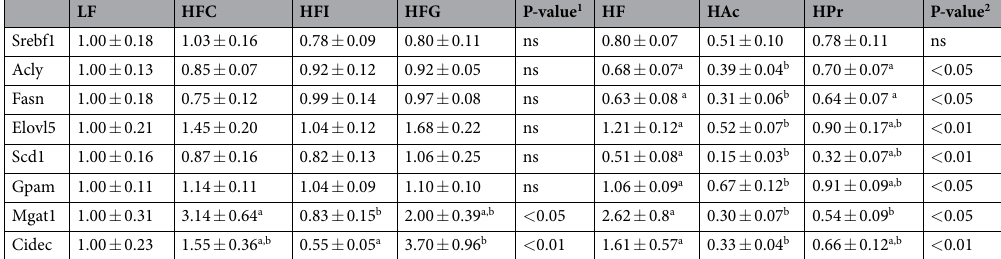
pseudolongum (Fig. 4E). Overall, dietary SCFA supplementation did not affect faecal microbiota composition on phylum or genus level (Supplementary Figure 3). However, HAc feeding also increased the abundance of Bifidobacterium animalis .